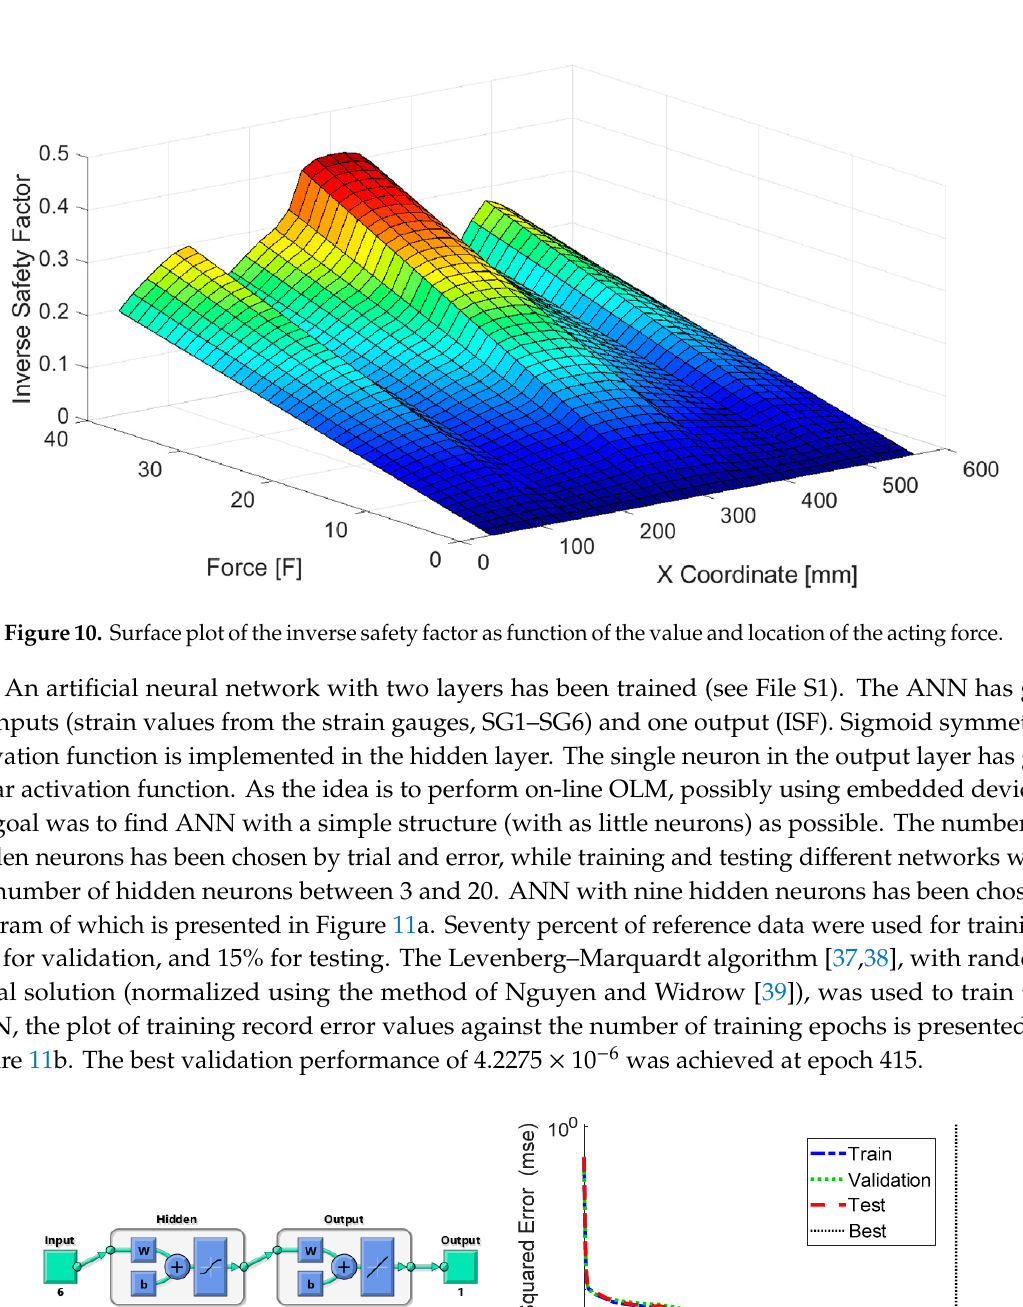
Figure 11. Trained artificial neural network (ANN): ( a ) architecture and ( b ) training performance.